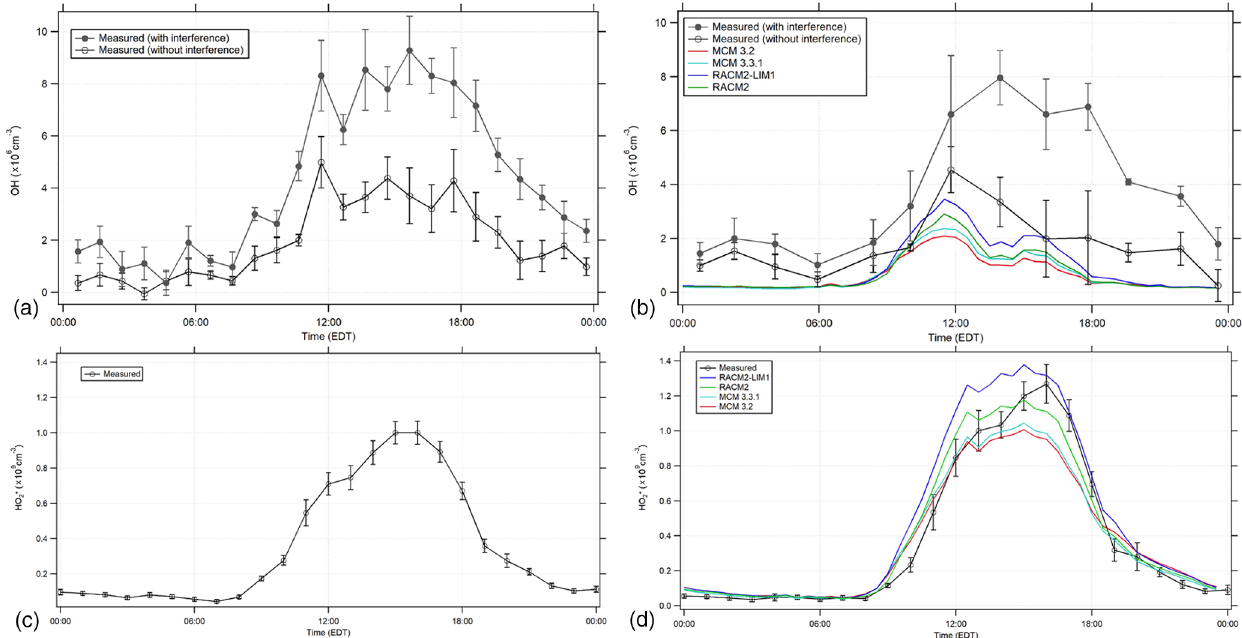
Figure 5. Diurnal profiles of OH (a, b) and HO ∗ (c, d) with the RACM2, RACM2-LIM1, MCM 3.2, and MCM 3.3.1 model results. (a, c) 2 illustrate the average of all measurements during the campaign, while (b, d) illustrate the average measurements when NO was measured simultaneously (see text). The open circles represent the 1 or 2h mean ± 1 σ standard error of OH and HO ∗ measurements. The filled circles 2 represent the 1 or 2h mean ± 1 σ standard error of the OH measurements with the